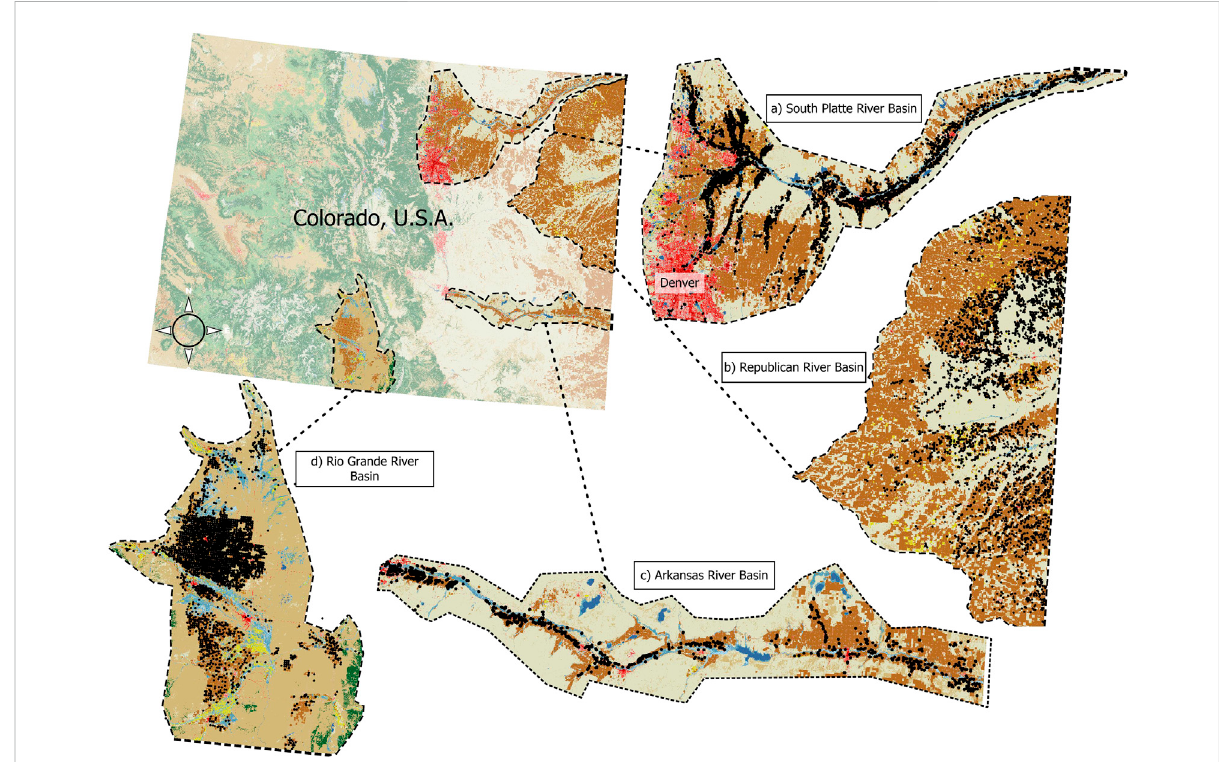
FIGURE 1 A map of the four study basins across Colorado, U.S.A. Black dots indicate the distribution of active groundwater wells across each basin as of 2015. Each basin has been enlarged to show detail and are not to scale with one